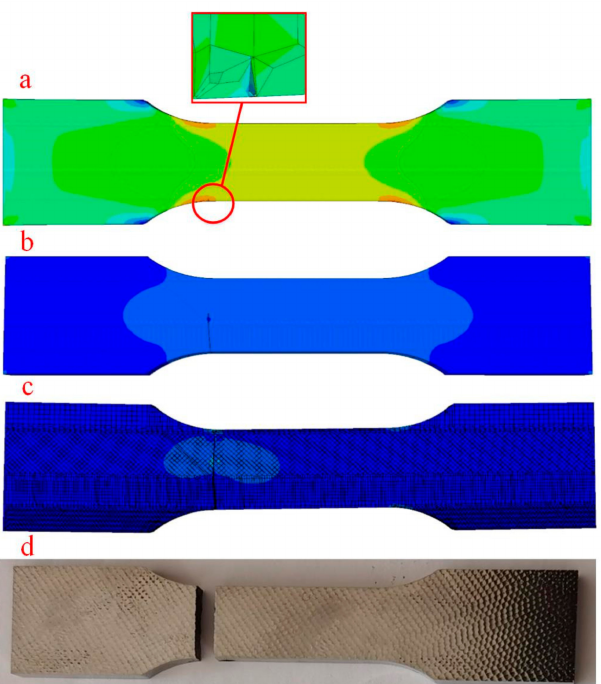
Figure 9. Comparison of fatigue crack growth process of fatigue specimen model with random irregular disorder pits and test results: ( a ) initial crack initiation; ( b ) crack growth; ( c ) fatigue fracture; ( d ) fatigue fracture test results.